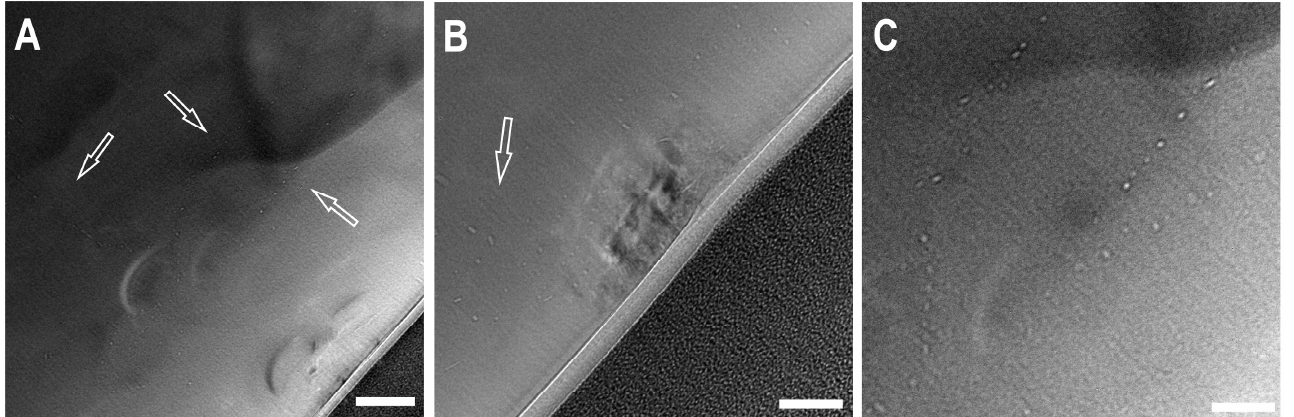
Figure 8. Transmission Electron Microscopy images of a foil from the “large” ballas. Small bright spots (in ( A , B ) pointed by arrows)—inclusions, possibly fluid. Scale bar—for ( A )—200 µm, for ( B , C )—100 µm. The black region in the bottom right part — Pt protective layer used for sample preparation by FIB.